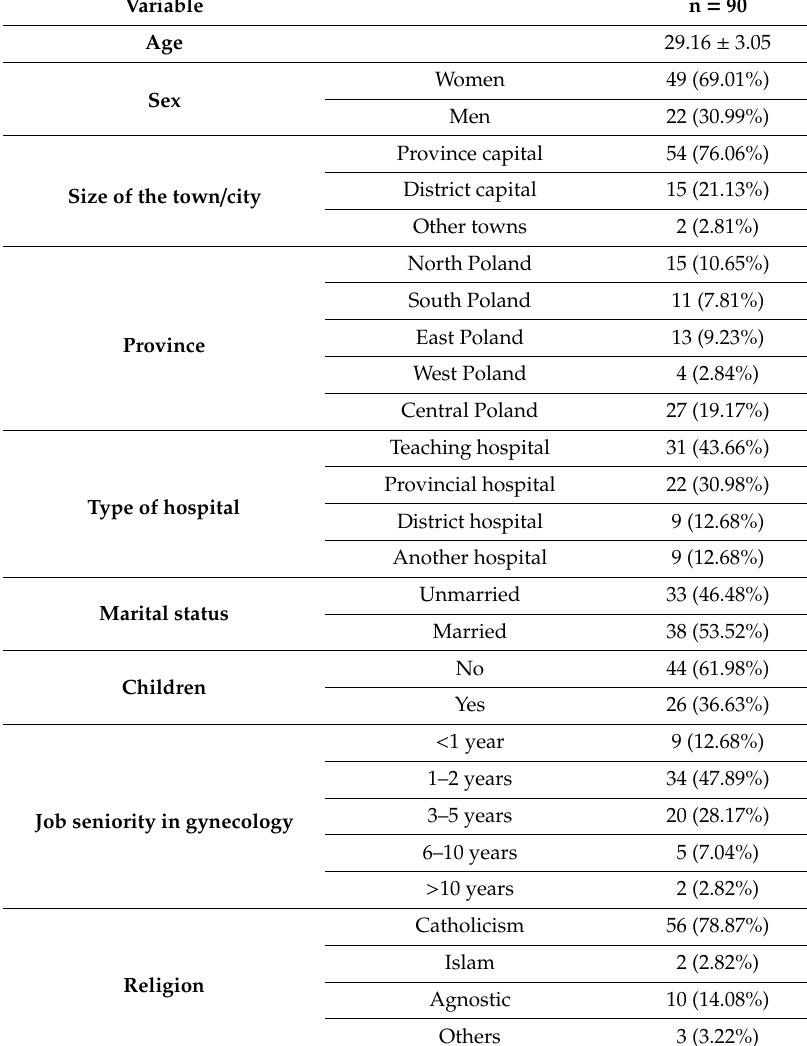
Table 1. General description of the group